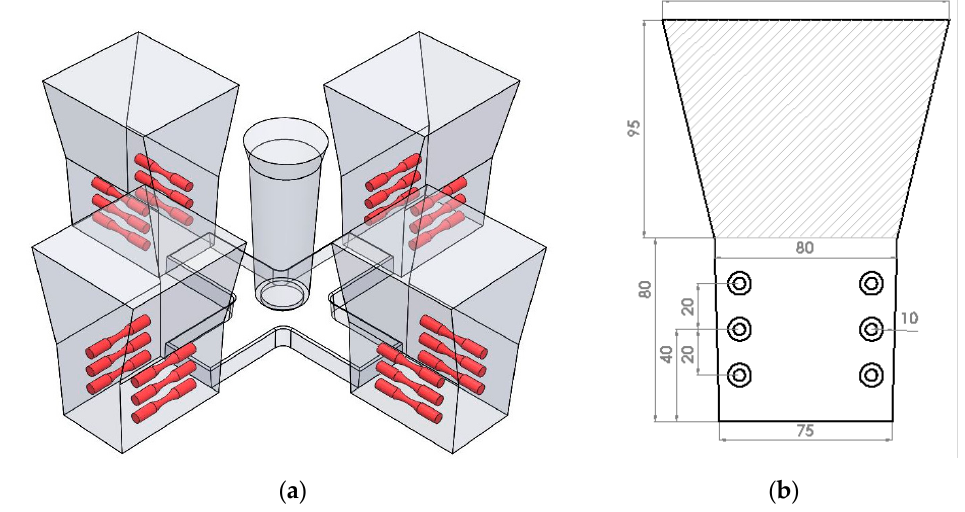
Figure 1. Casting with specimen in rotating bending isometric view ( a ) and side view in mm ( b ). Table 1. Chemical composition of the three processed melts, contents in wt.%.